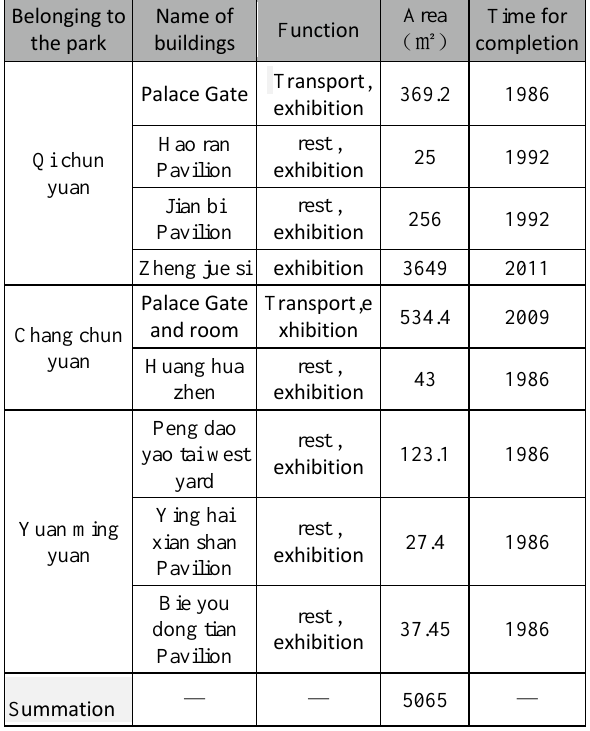
Table 2 The old Summer Palace rehabilitation of buildings